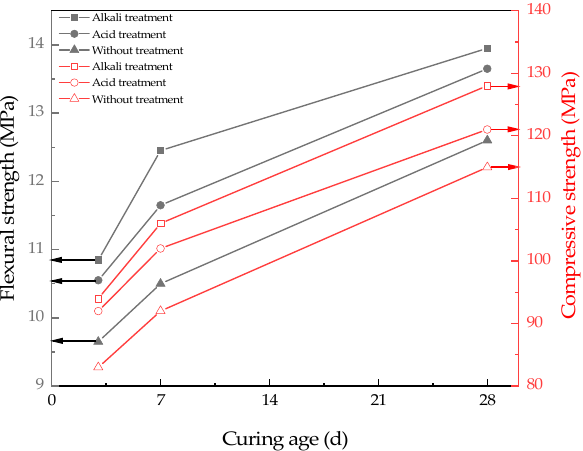
Figure 11. Mechanical strengths of alkali-activated BFS with different treatment methods.